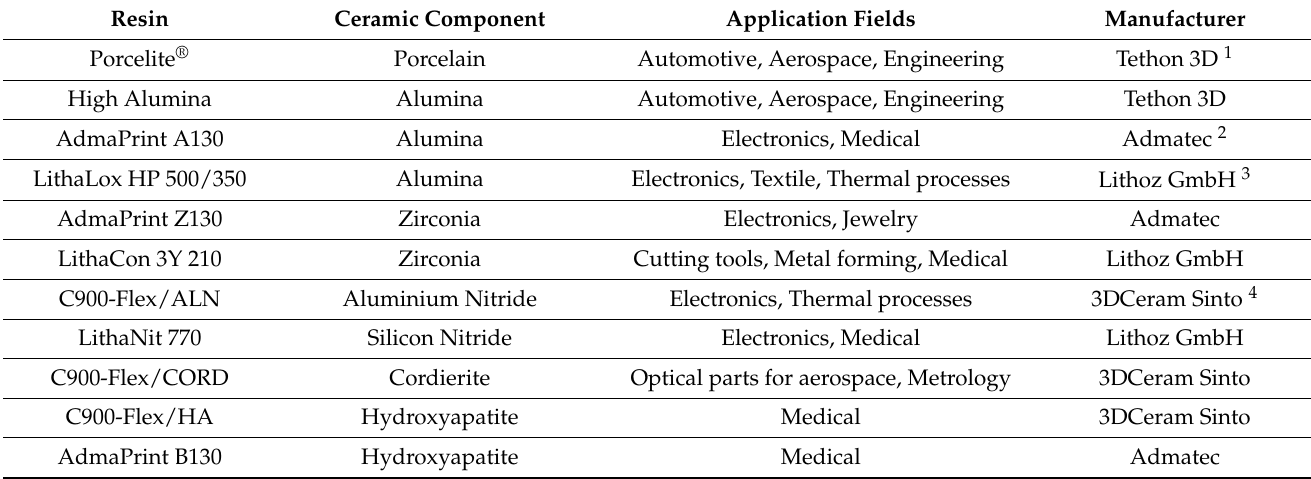
Table 3. Commercial resins available in